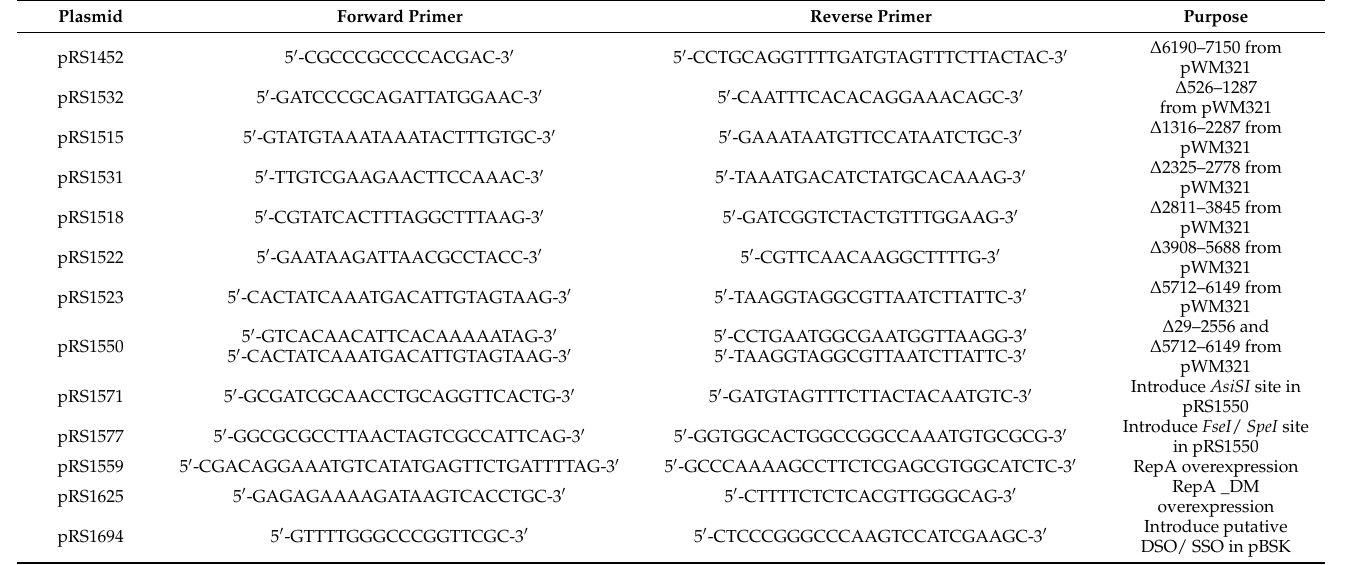
Table 3. Primers used in this